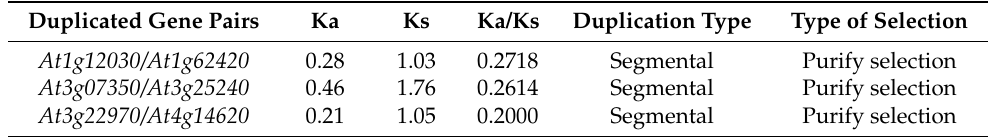
Table 2. Synteny analysis of DUF506 genes in